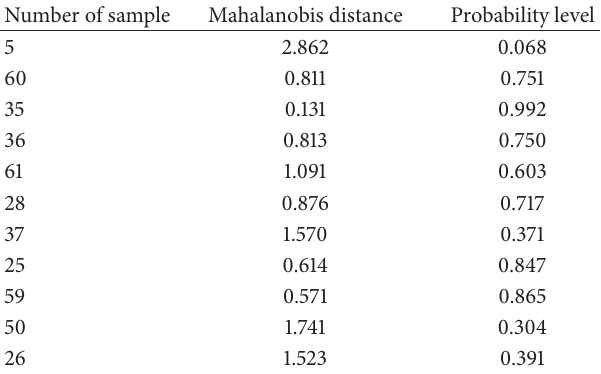
Table 2: Mahalanobis distance and its probability level of each sample in the reference class.